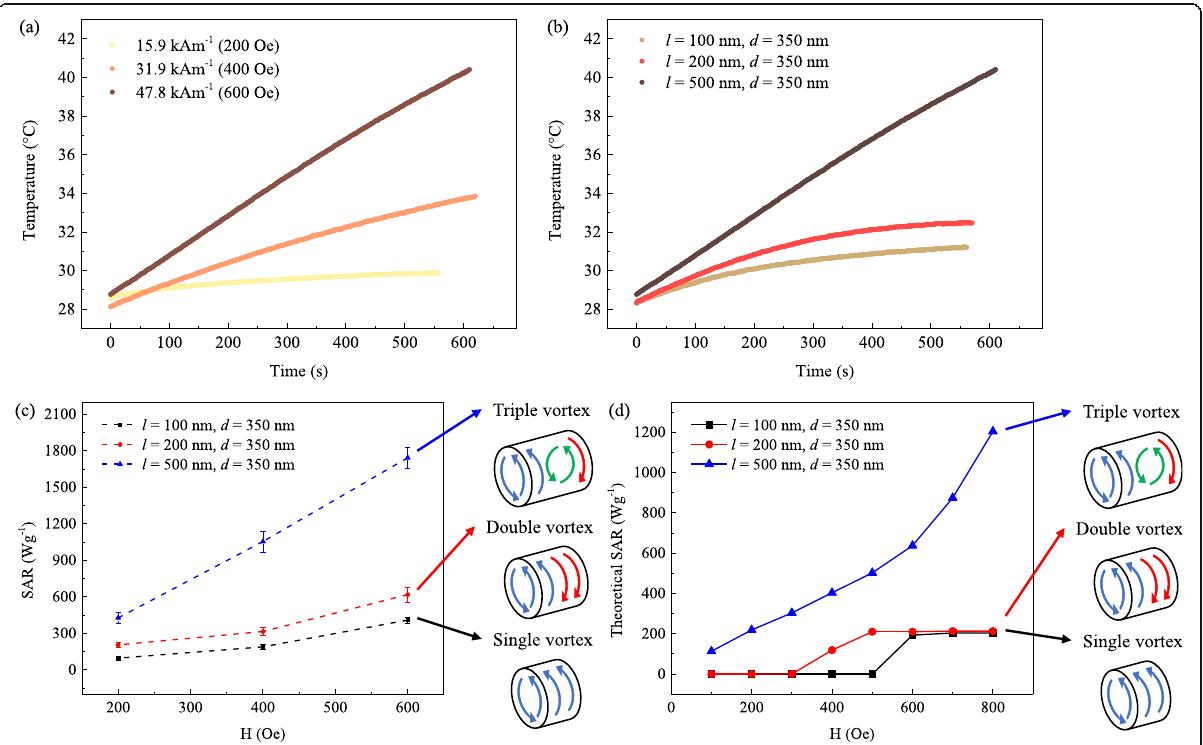
Fig. 4 a Temperature-time curves of NiFe MNPs, with l = 500 nm and d = 350 nm, for increasing magnetic field strength from 15.9 to 47.8 kAm − 1 (200 to 600 Oe). b Temperature-time curves of NiFe MNPs, with d = 350 nm. The magnetic field strength of 47.8 kAm − 1 (600 Oe), while the MNP length l increased from to 500 nm. c Tabulated SAR values for NiFe MNPs, with l = 100 – 500 nm and d = 350 nm under a magnetic field strength of 15.9 to 47.8 kAm − 1 (200 to 600 Oe). d Theoretical SAR values for NiFe MNPs, with l = 100 – 500 nm and d = 350